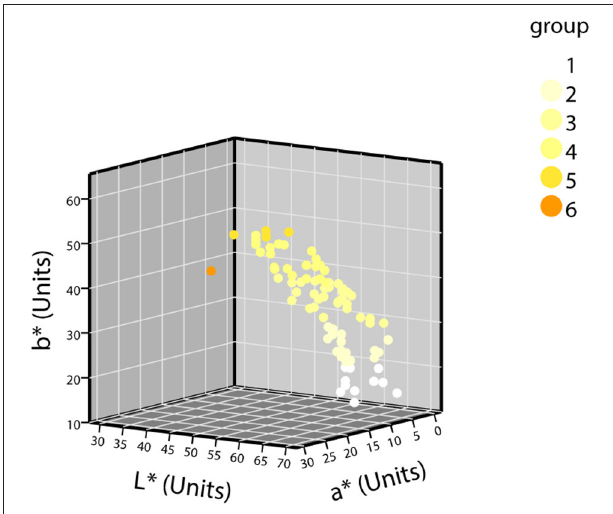
FIGURE 3 | The distribution of CIE L*a*b* values of normal urine samples in a three-dimensional space ( n =